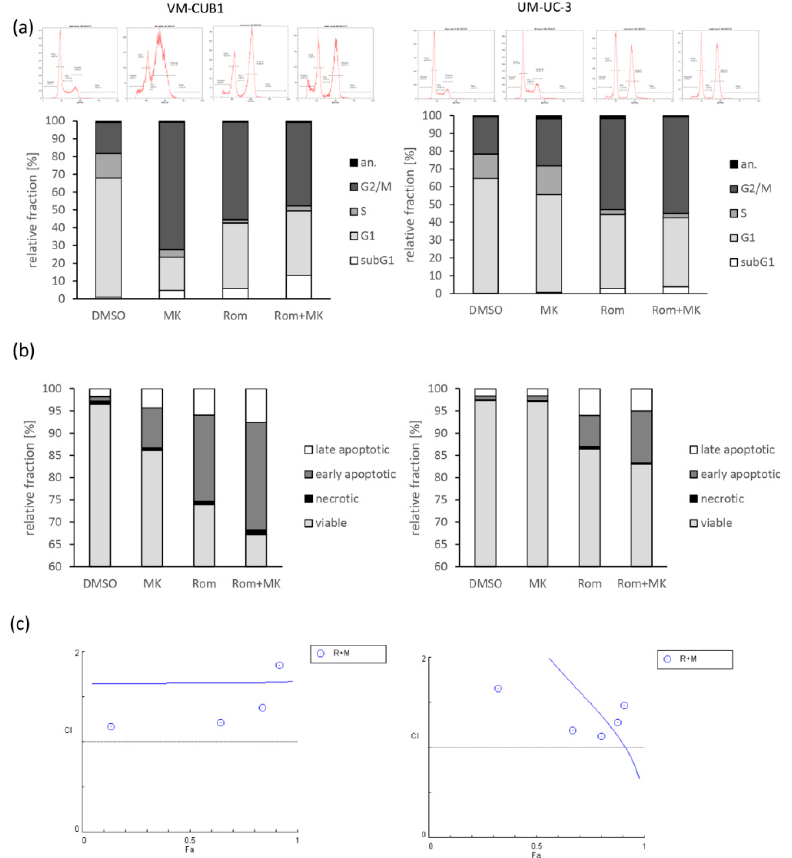
Figure 9. Effects of combined treatment on cell cycle and cell death induction. ( a ) Cell cycle alterations were monitored by PI staining and flow cytometry 24 h and 48 h after single or combined treatment (DMSO, MK, Rom, Rom + MK). Example raw data from a representative experiment is displayed. Means of independent experiments for percentages of cells in the respective gates after 48 h are illustrated in bar graphs. ( b ) Induction of cell death was measured by Annexin V/PI staining and flow cytometry 24 h and 48 h after the indicated combined or single treatment. Means of independent experiments for percentages of cells in the respective quadrants after 48 h are illustrated in bar graphs. ( c ) Combination index (CI) plots for the combination of Romidepsin and MK-1775 (R + M). Cell viability was measured at six constant dose ratios by MTT assay after 72 h treatment. Actual applied combination dosages are given in Table S4. Combination index versus the number of dead cells (Fraction affected: Fa) were calculated and CI plots were generated using CompuSyn software. CI < 1 indicates synergism, CI = 1 additive effects and CI > 1